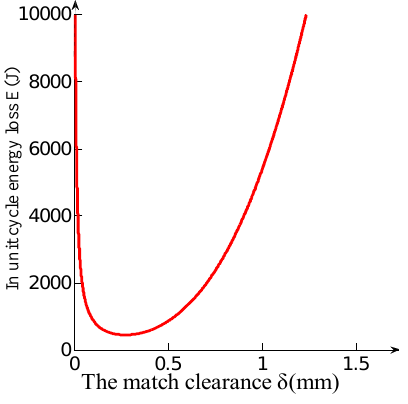
Figure 7. The energy loss changing with the fit clearances in a work cycle.